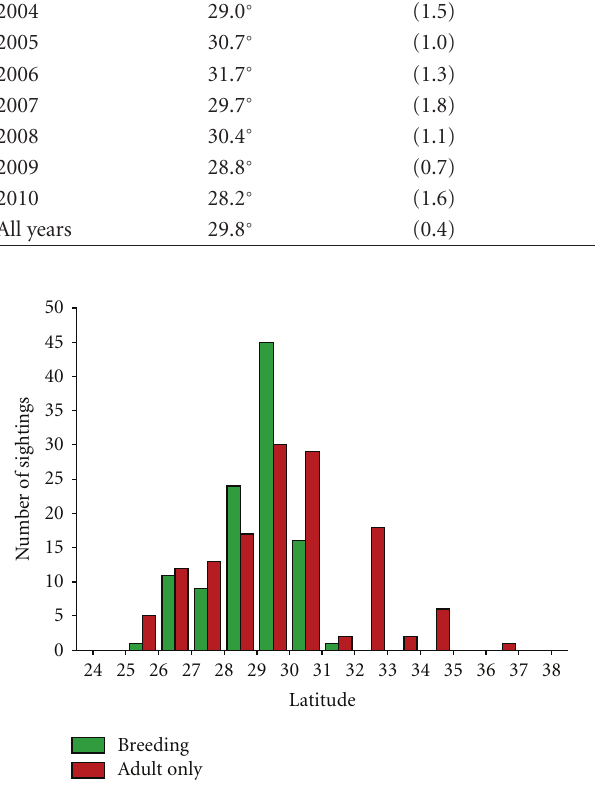
Figure 3: Distribution of the sighting latitude of adult and breeding monarch butterflies in January and February from 2002 to